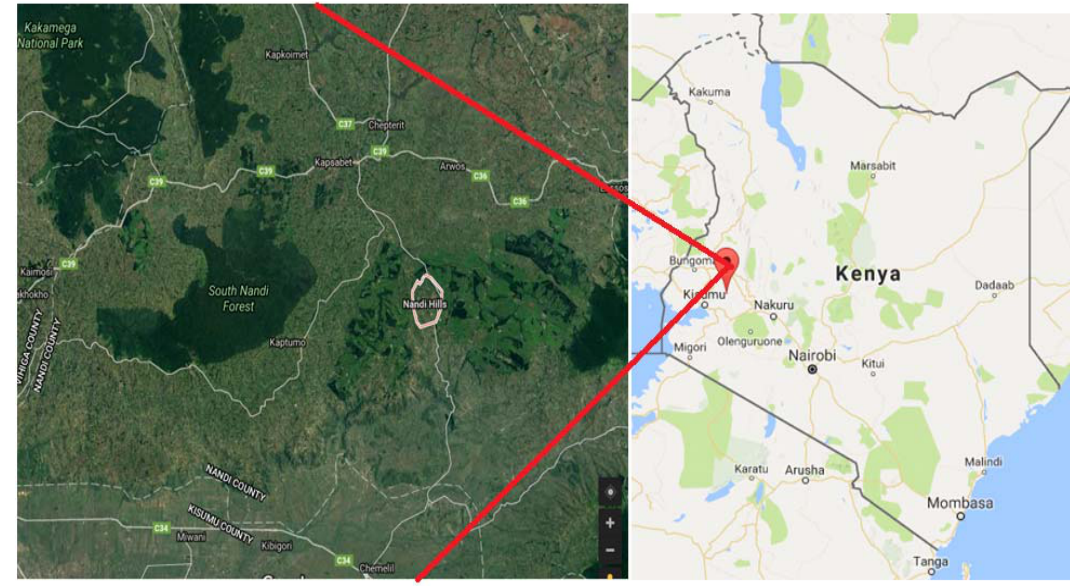
Figure 1. Map of the area of study (Source: Edited from [17]).